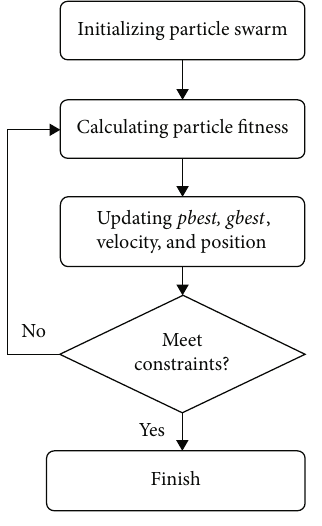
Figure 4: PSO algorithm fl